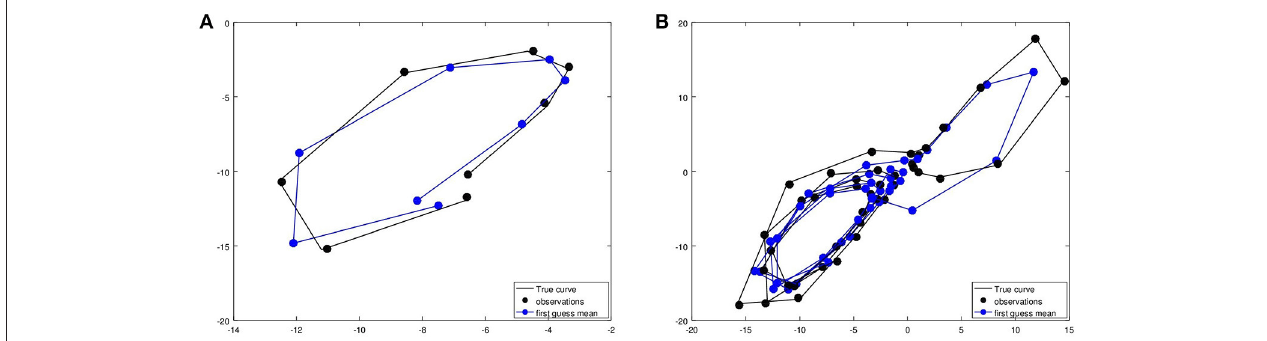
FIGURE 2 | We show the results of the ultra rapid data assimilation in comparison with the ensemble Kalman square root filter for the Lorenz 1963 model for N assimilation steps. In (A) , the black curve is the original, black dots are the observations. The mean of the analysis ensemble of the ultra rapid data assimilation URDA after k 8 assimilation steps is shown in pink, where we need to note that here the information of the data is used to update the full curve at all points (i.e., the = estimate of the past is updated as well. The red curve shows the analysis ensemble mean of the sequential ensemble Kalman square root filter. (B–D) show the sequential error curves of the analysis error, pink for URDA, red for the ensemble Kalman square root